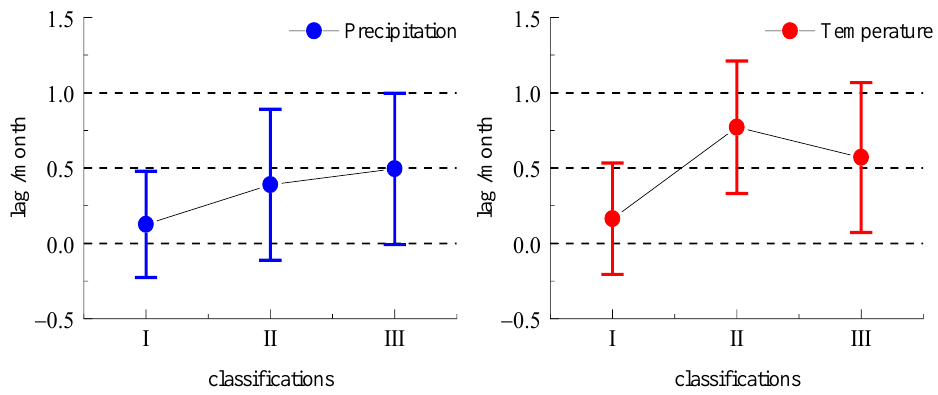
Figure 10. Average values (dot) and standard deviations (I-shaped lines) of the lag patterns detected by method 2. I—Mixed Forest; II—Grassland; III—Barren or Sparse Vegetation.